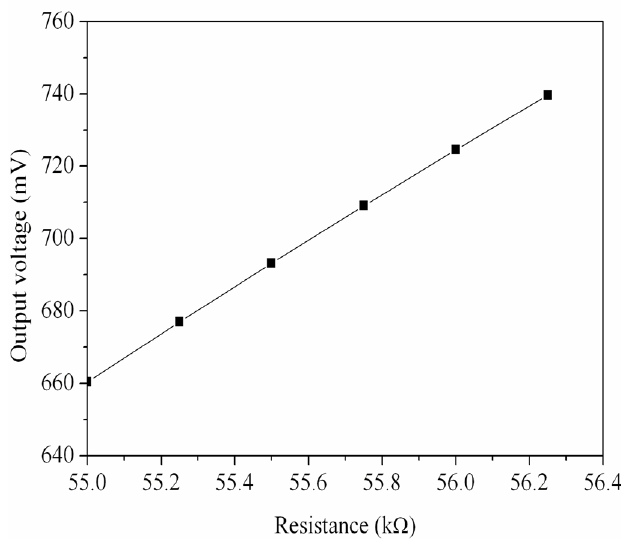
Figure 2. Simulated results of the output voltage for the ammonia